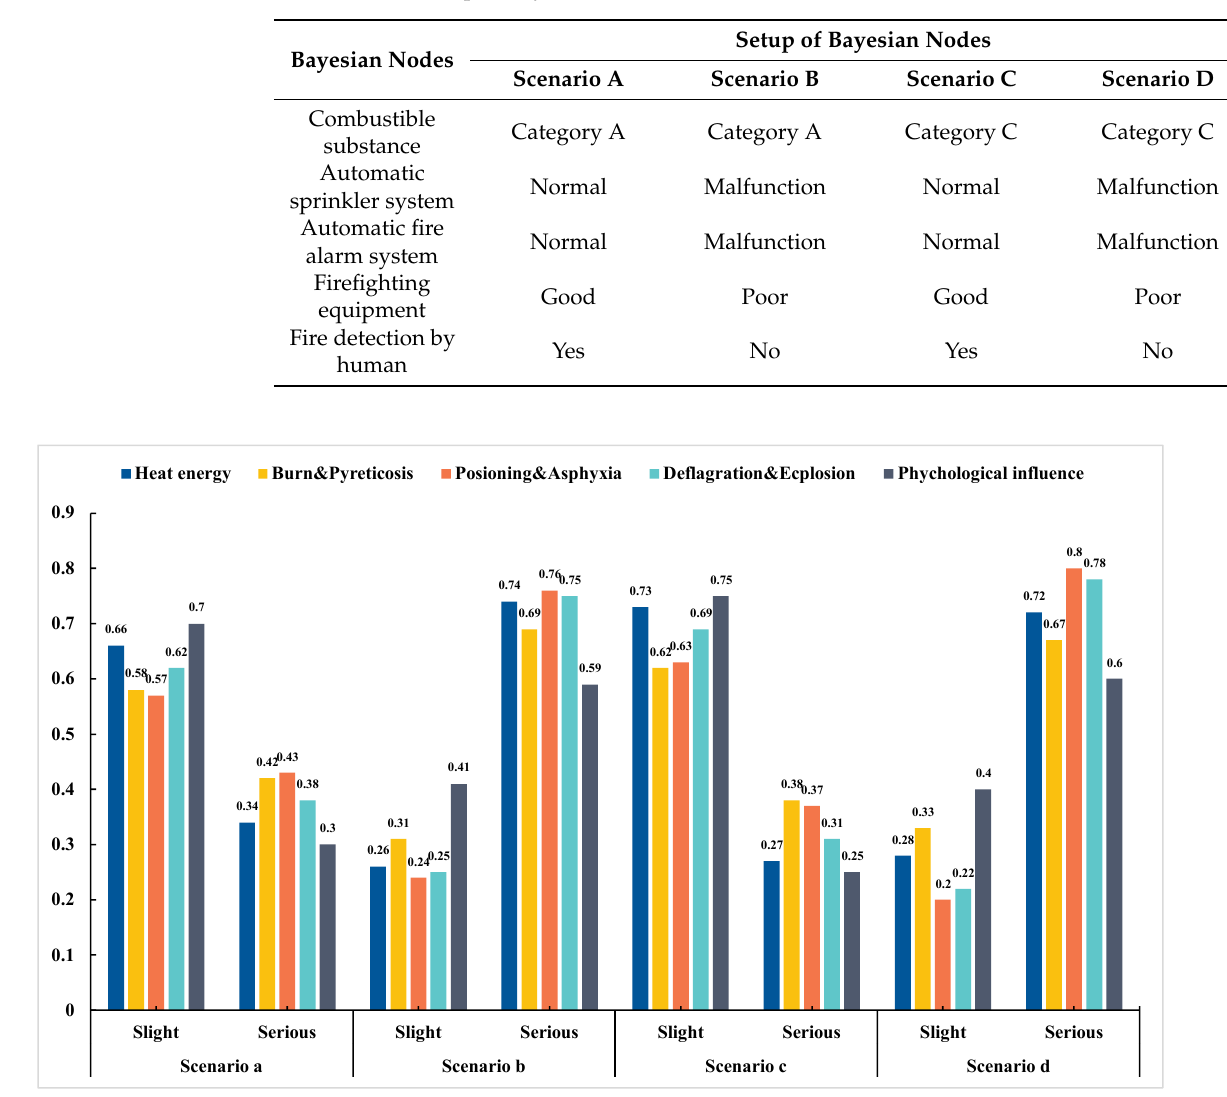
Table 5. Initial setup of Bayesian nodes.